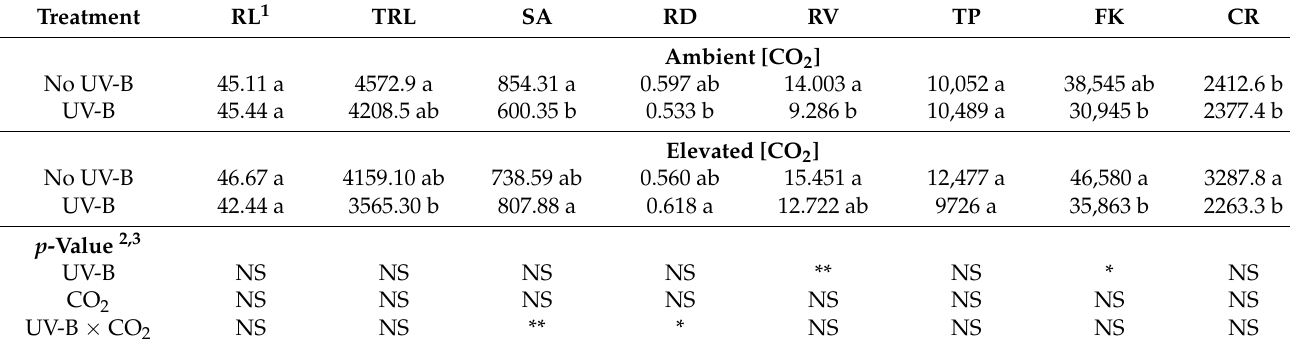
Table 3. The mean root length (RL), total root length (TRL), surface area (SA), root diameter (RD), root volume (RV), tips (TP), forks (FK), and crossings (CR) of the roots of basil plants grown without UV-B radiation (No UV-B) and with 10 kJ m − 2 d − 1 UV-B radiation (UV-B) at 420 and 720 ppm CO 2 concentrations (ambient [CO 2 ] and elevated [CO 2 ], respectively) after 17 days of treatment.